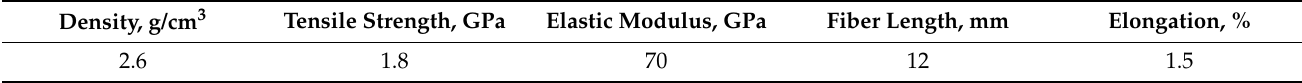
Table 9. Physical and mechanical characteristics of glass fiber.